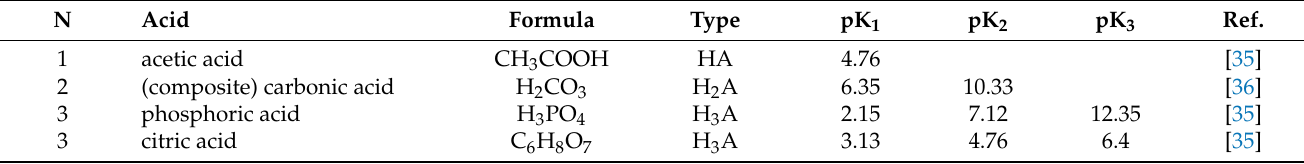
Table 1. pK values for four N-protic acids at 25 ◦ C. (The composite carbonic acid is the sum of the unionized species CO 2 (aq) and the pure acid: H 2 CO 3 * = CO 2 (aq) + H 2 CO 3 ; to simplify the notation, we omit the asterisk (*) on H 2 CO 3 * throughout the